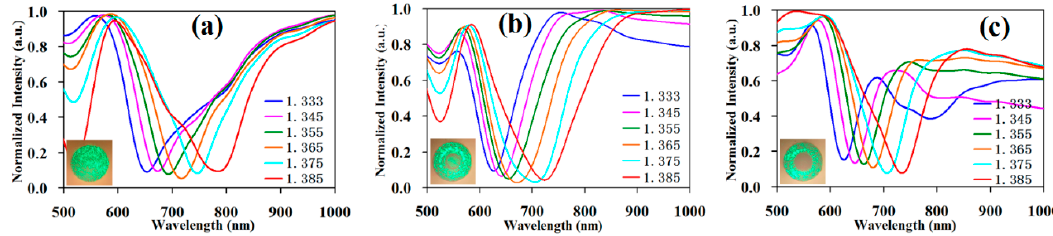
Figure 6. The testing data of the three types of fiber cladding SPR sensors are renormalized. ( a ) Normalization of the testing data of the single-mode fiber cladding SPR sensor; ( b ) normalization of the testing data of the gradient refractive index multimode fiber cladding SPR sensor; ( c ) normalization of the testing data of the step refractive index multimode fiber cladding SPR sensor.